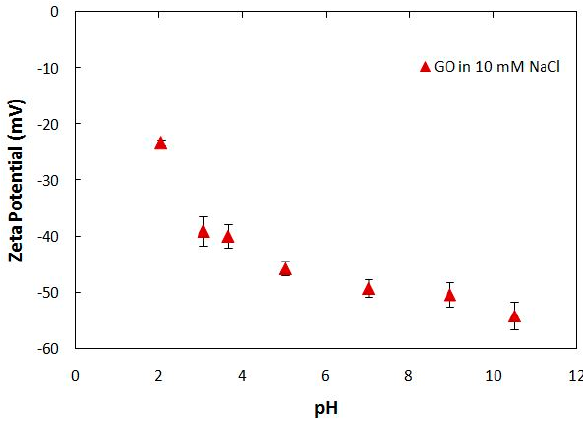
Figure A3. Visualization of graphene sheets via transmission electron microscopy (TEM).